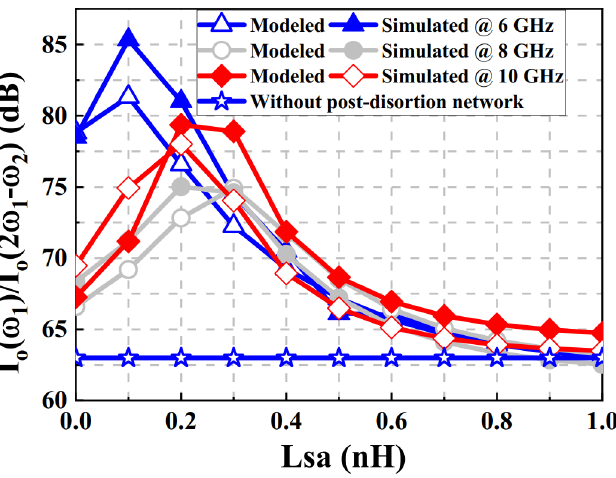
Figure 11. Comparison of calculated and simulated normalized third-order intermodulation distor- tion (linearity improvement) of the combined current versus L sa and frequency with and without modified post-distortion network based on the above equations.